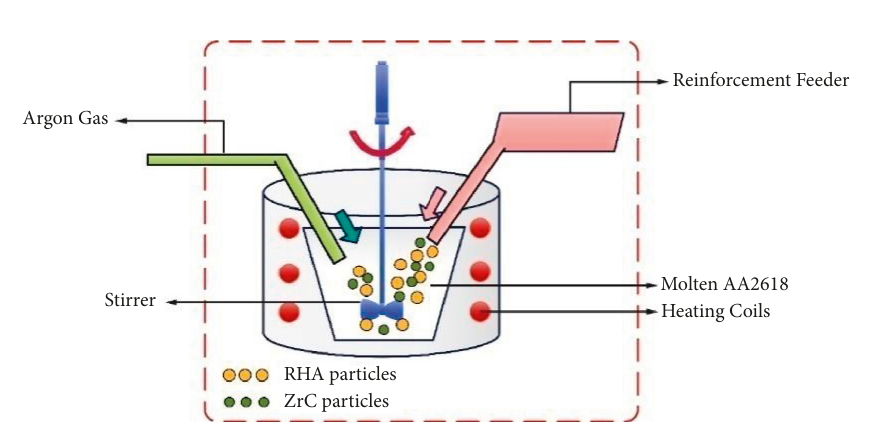
Figure 1: Stir casting